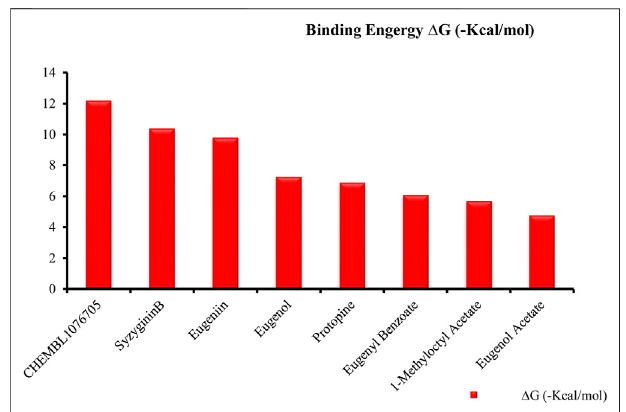
FIGURE 1 | Graphical representation of top-ranked phytochemicals docked against the M Pro unit of binding energy [ Δ G ( −